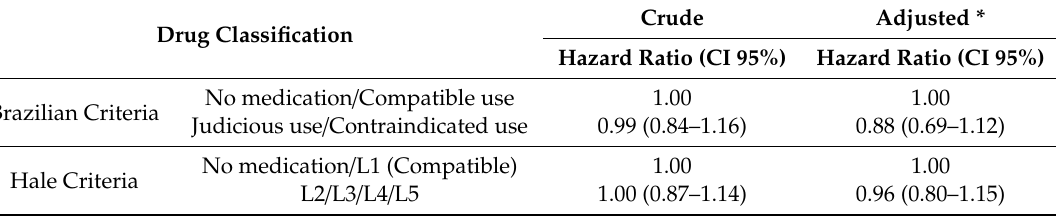
Table 4. Relationship between drug use during the first three months postpartum and weaning at 12 months (excluding women who weaned before 3 months), controlled for confounding variables, considering Hale’s lactation risk categories [16] and Brazilian Ministry of Health criteria [17]. Pelotas (Brazil) Birth Cohort Study, 2015.